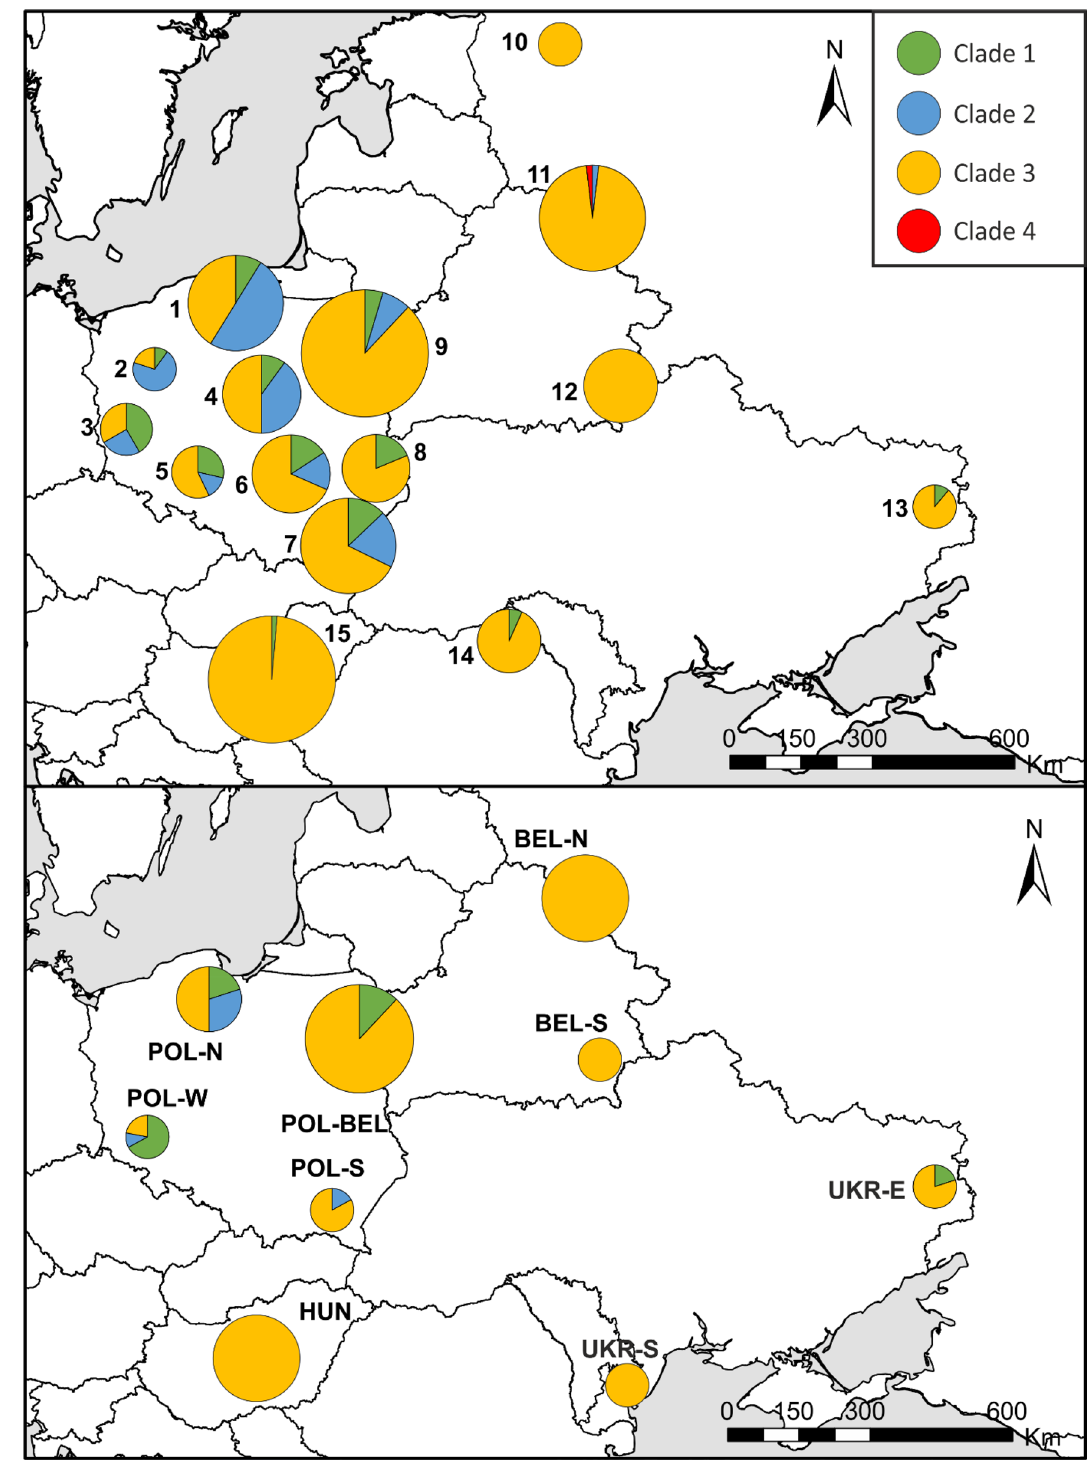
Figure 5. Frequencies of mtDNA clades of wild boar populations based on D-loop (upper panel) and mitogenomic analyses (lower panel). The maps were created with the ArcGIS software 10.3.1. based on source map from ESRI https:// www. esri. com/ en- us/